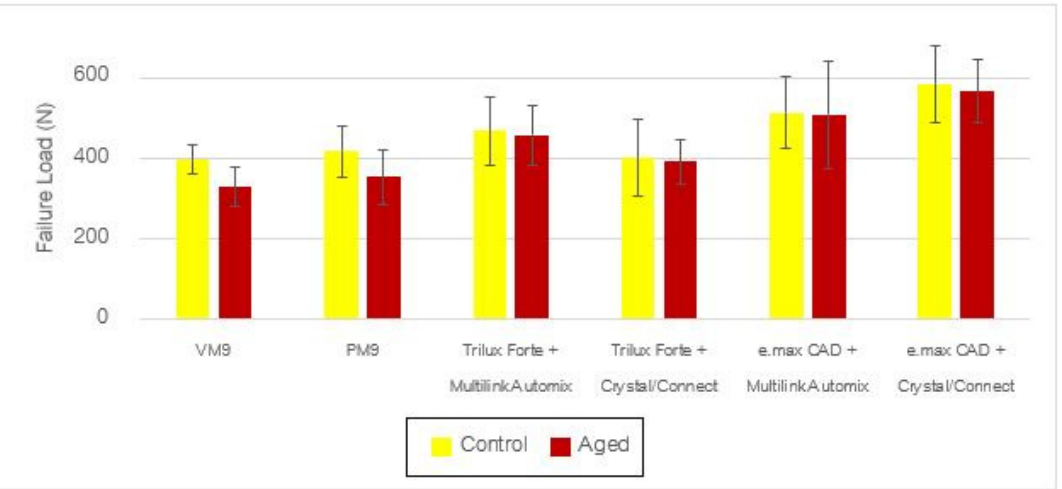
Figure 3. Failure load of bilayered veneer zirconia in control group (before the simulated aging) compared with after simulated aging.